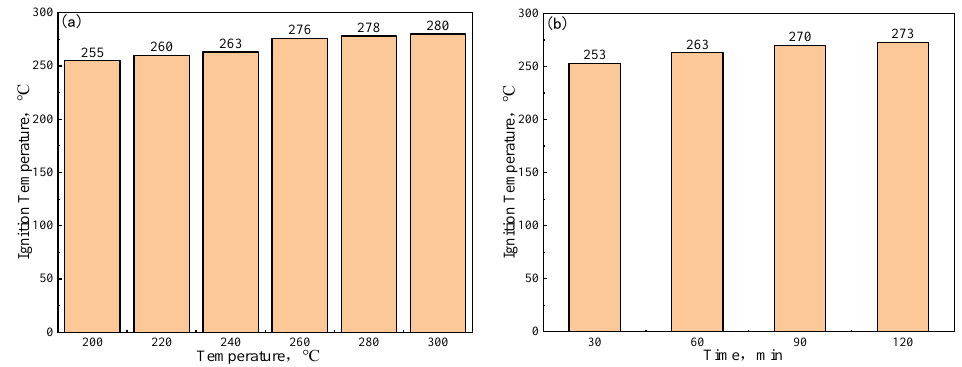
Figure 8. Ignition temperatures of different hydrochar: ( a ) different temperatures; ( b ) different holding times.